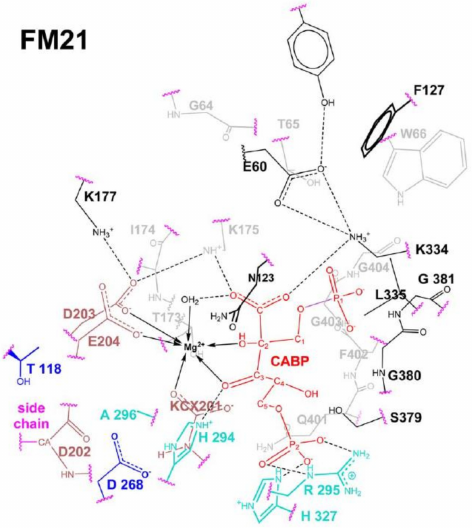
Figure 11. Structure of the FM21 model consisting of 339-342 atoms around the Mg 2+ cation. Where residues overlap visually, residues at the back are shown in gray and residues at the front are shown in thick black lines. Truncations from enzyme are highlighted as wavy lines in magenta. Only one water molecule coordinated to Mg 2+ is shown. (Figure 11 from ref. [41], used by permission of John Wiley and Sons (copyright ©